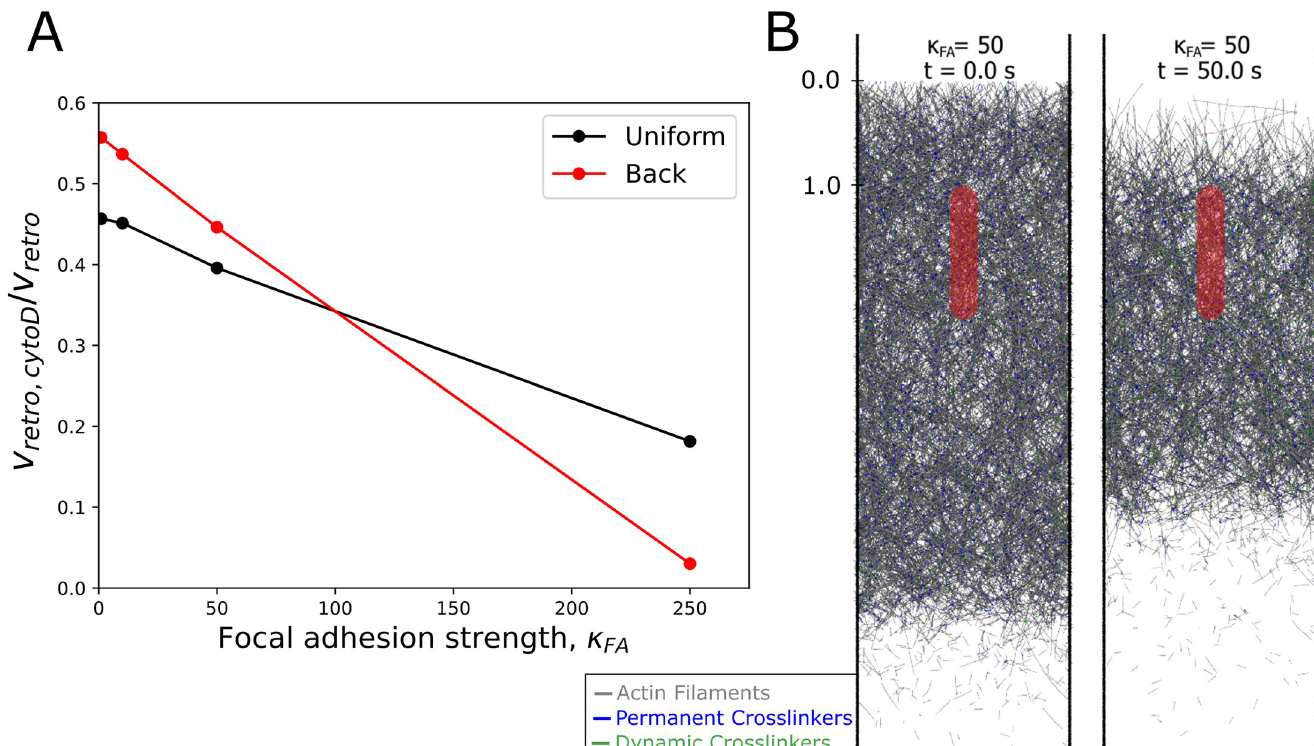
Fig 5. Simulated effect of cytochalasin D on retrograde flow speed captures experimental results. (A) Effect of addition of cytochalasin D was modeled as stopping addition of filaments after reaching steady state. The retrograde flow speed v retro , cytoD was measured between 30–35 s after stopping filament addition and compared to the prior retrograde flow speed at steady state, v , as a function of focal adhesion strength. Both velocities are averages over all filament beads. (B) Representative retro snapshots of the simulated effect of cytochalasin D addition at the time of addition ( t = 0) and at t = 50 s from a pull back simulation. The perturbation results in retreat of the actin network from both the leading edge due to retrograde flow without addition of filaments and from the back due to filament disassembly. The scale along the vertical ( y ) axis is in μm . Blue (green) line segments represent permanent (dynamic) crosslinkers.